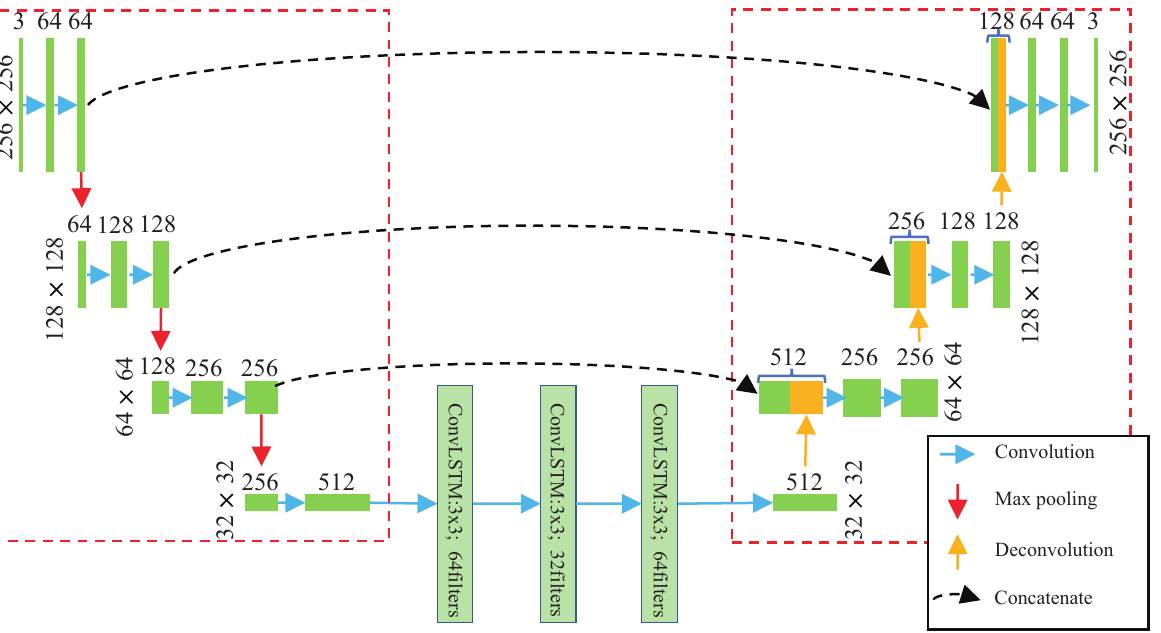
Figure 3. The detail of the network structure of our work. There are three zones in the network, in which the left zone is called the encoder, the right zone is called the decoder, and the rest of the structure in the middle is the LSTM